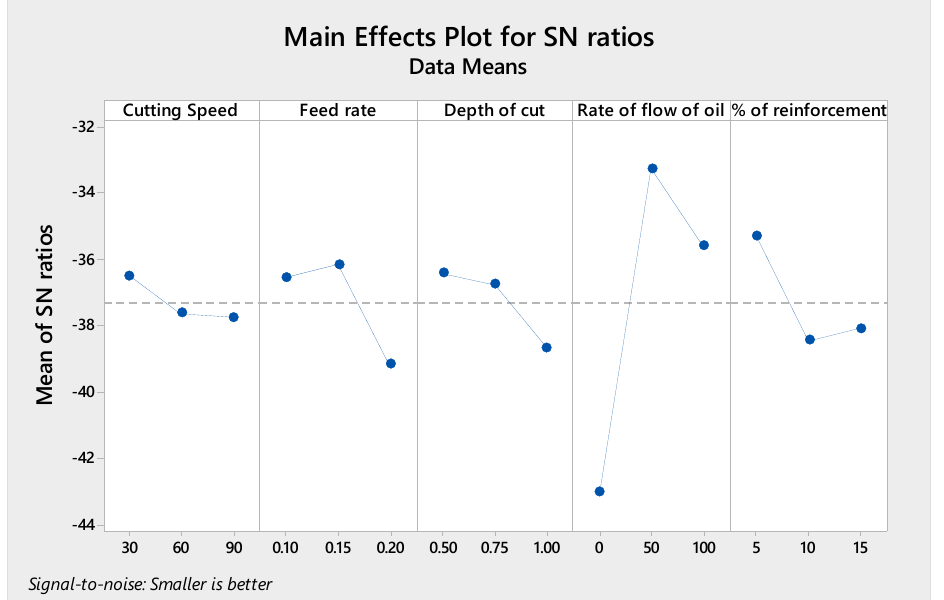
Figure 11. S/N ratio plots for tool wear.